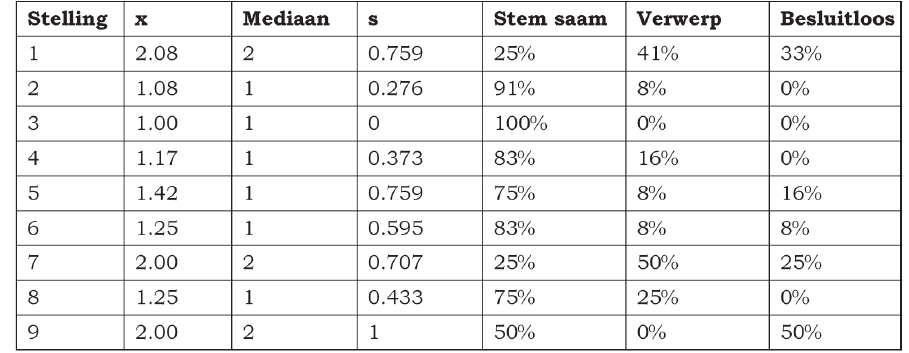
7.1 Beskrywende statistiek rakende respondente se opinies ten opsigte van sekere stellings rondom direkte bemarking TABEL 1: Respondentopinies oor sekere stellings rondom direkte